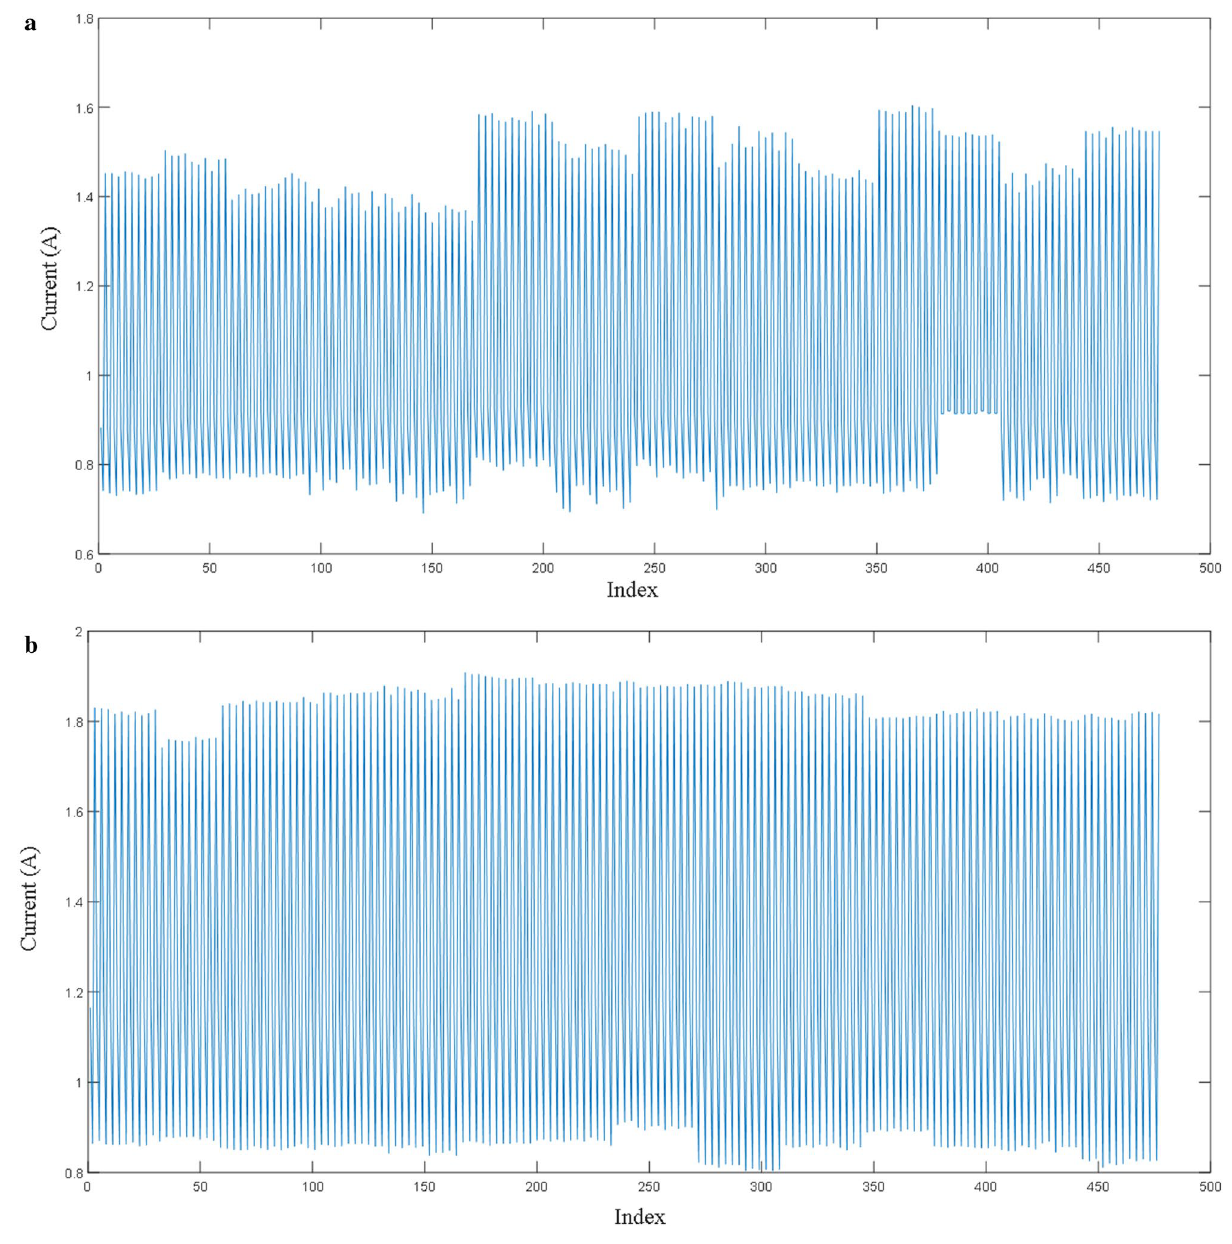
Figure 6. ( a ) Open process time series. ( b ) Close process time